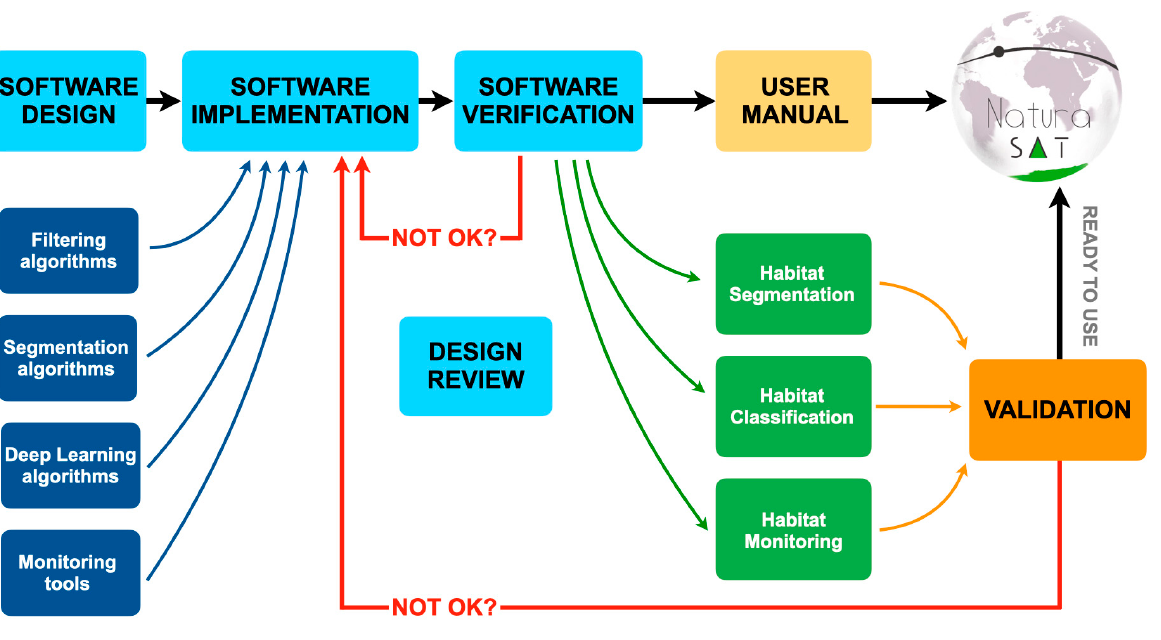
Figure 1. The diagram of development and functionalities of the NaturaSat